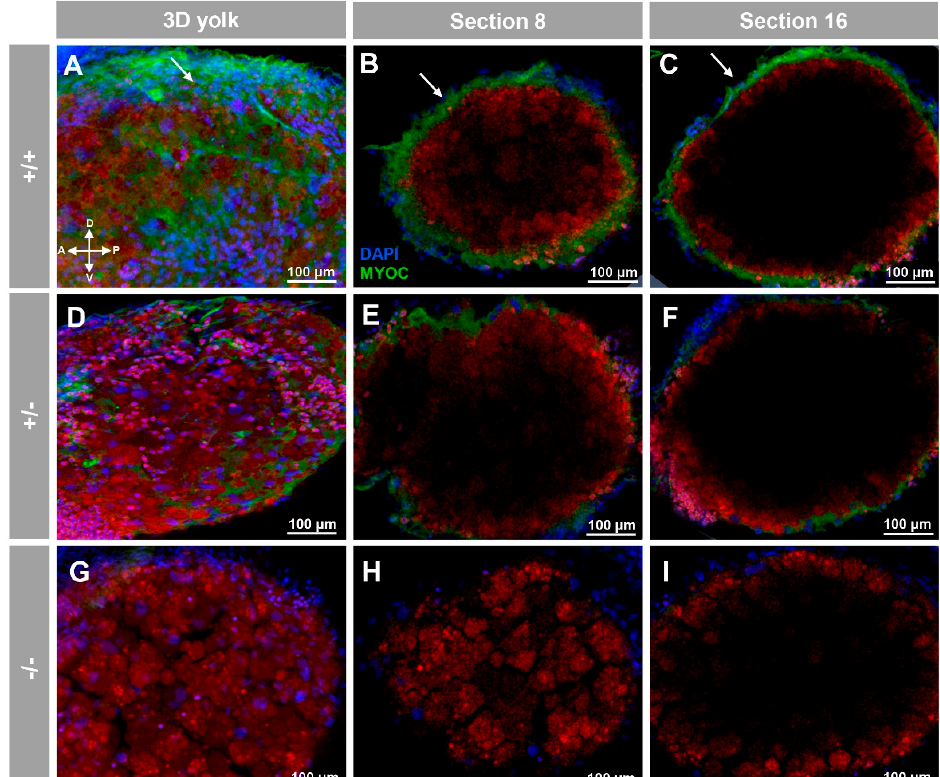
Figure 3. Fluorescent whole-mount immunohistochemical detection of myoc in the yolk of zebrafish larvae (96hpf). Wild-type ( A – C ), heterozygous ( D – F ) and homozygous ( G – I ) myoc mutant embryos were incubated with chicken anti-myocilin (TNT) primary antibody and a Cy2-conjugated goat anti-chicken IgY secondary antibody. Three-dimensional reconstruction from z-stack scanned confocal microscopy images ( A , D , G ) of the yolk. Sections (92 µm) 8 ( B , E , H ) and 16 ( C , F , I ), were selected from z-stack images to show the precise localisation of the green signal on the yolk’s surface (arrows) ( A – C ). Blue: DAPI nuclear staining. Green: Cy2-conjugated goat anti-chicken IgY secondary antibody. Red: tissue autofluorescence. The cross indicates the position of the embryonic axes (D: dorsal; P: posterior; V: ventral; A: anterior). The images are representative of the result observed in 10 embryos. The negative controls are shown in Figure S3D–F. Two-dimensional confocal image z-stacks are show in supplementary video 2.